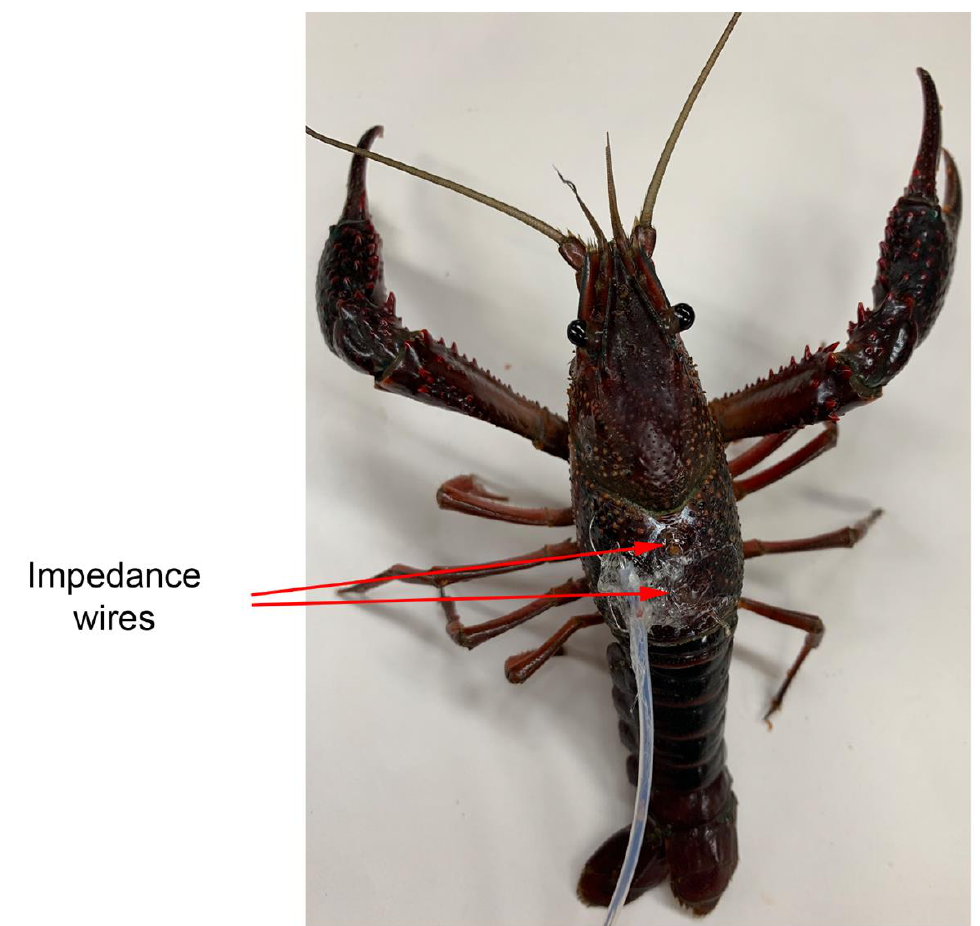
Figure 1. Placement of recording leads for measuring heart rate in an electrocardiogram (ECG) for